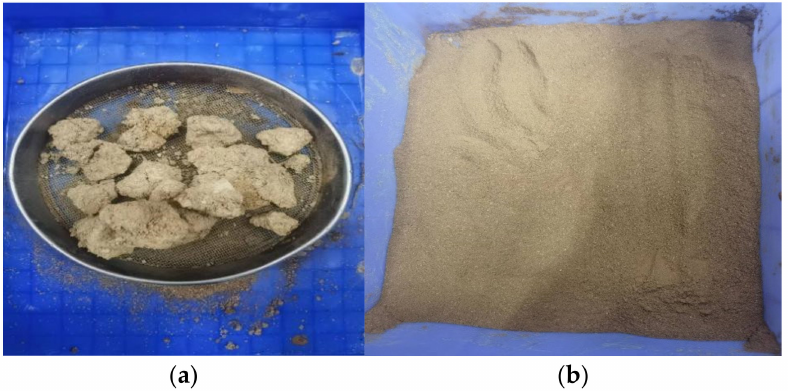
Figure 17. ( a ) Drying clay; ( b ) Fine soil through 2 mm sieve.